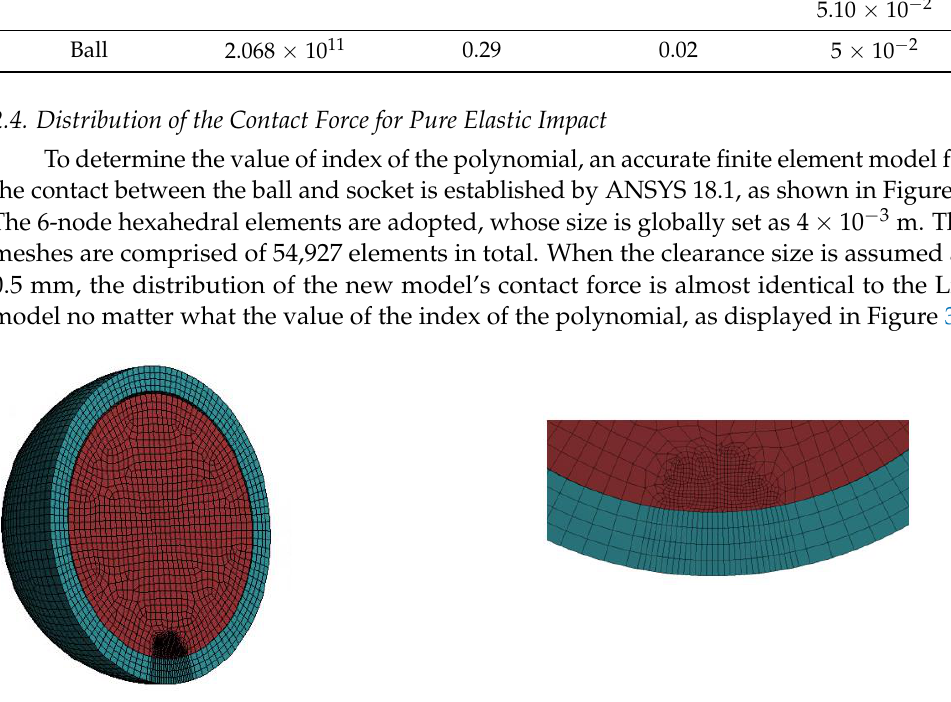
Figure 2. Finite element model of the spherical joint with clearance.